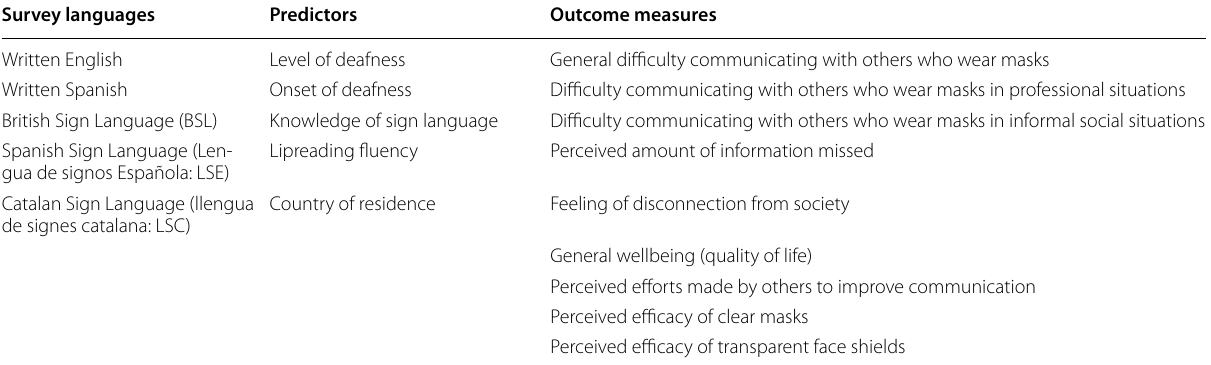
Table 1 Summary of the current research Survey